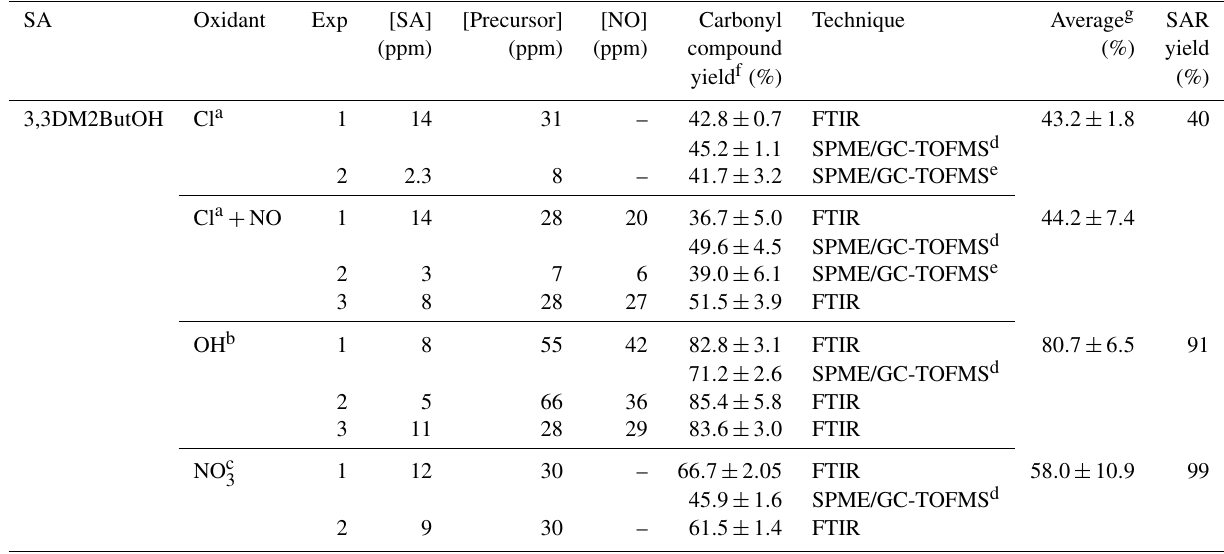
Table 5. Experimental conditions and molecular yields of 3,3-dimethyl-2-butanone for the reaction of 3,3DM2ButOH with atmospheric oxidants. SA Oxidant Exp [SA] [Precursor] [NO] Carbonyl Technique Average g SAR (ppm) (ppm) (ppm) compound (%) yield yield f (%) (%) 3,3DM2ButOH Cl a 1 14 31 –